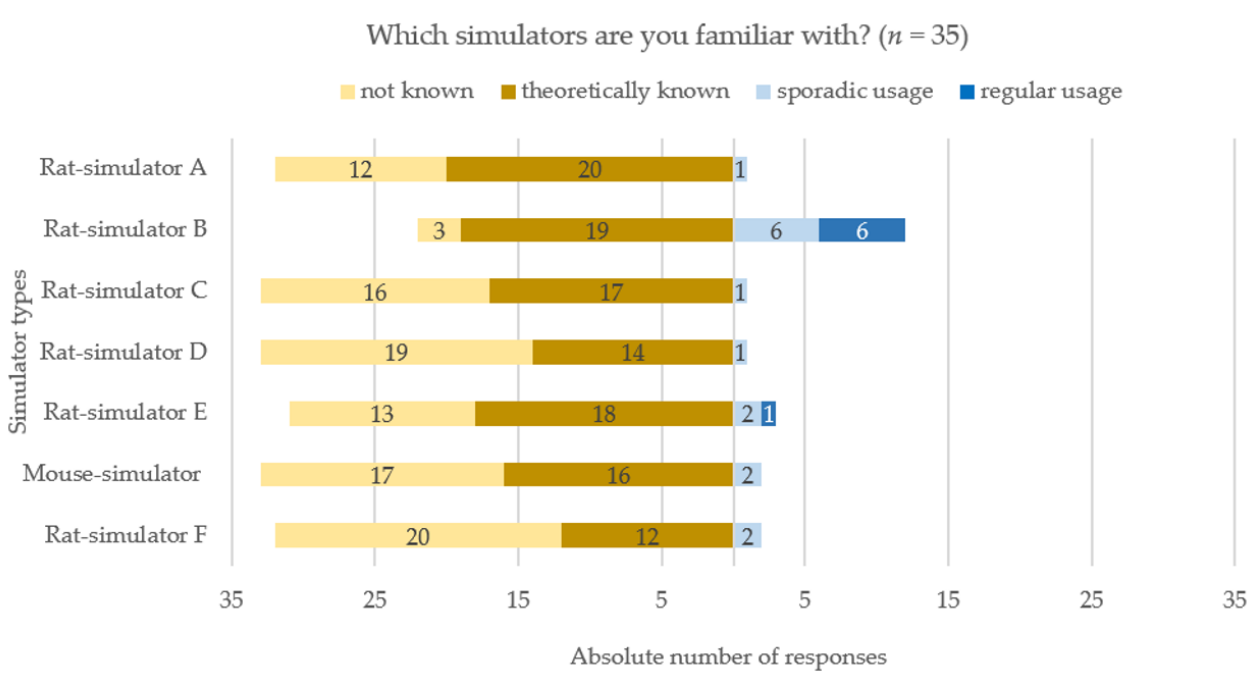
Figure 2. Descriptive analysis of the awareness and usage of currently available rat and mouse simulators derived from the single selection question “Which simulators are you familiar with?” for each simulator type. Distribution of replies concerning the type of rat or mouse simulator the respondents were familiar with, referring to the most frequently performed course type. Data are shown in a diverging stacked bar chart. Simulators are listed on the y-axis, response frequencies on the x-axis, ranging from “not known” (yellow) and “theoretically known” (brown) on left- to “sporadic usage” (light blue) and “regular usage” (dark blue) on the right-handed diverging stacked bars. Single selection question for each simulator type. Absolute number of responses is shown for each respective simulator in the corresponding bar ( n = 35).